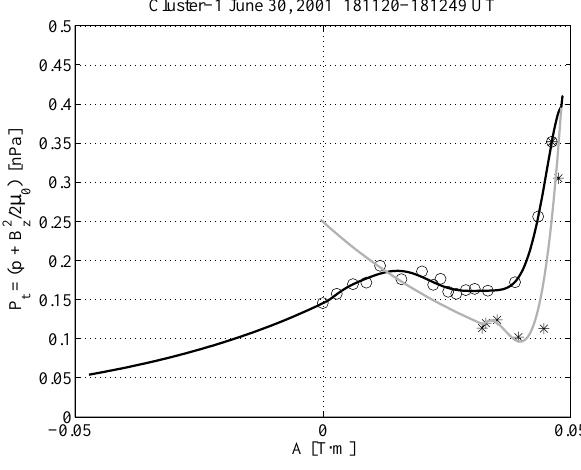
Fig. 2. Plot of transverse pressure P t versus computed vector po- tential A and the fitting curves for the C1 magnetopause cross- ing on 30 June 2001. The circles and stars are data used in pro- ducing the magnetosheath (black curve) and magnetospheric (gray curve) branches, respectively. Extrapolated parts for each branch are shown; these are outside the measurements but are required for the